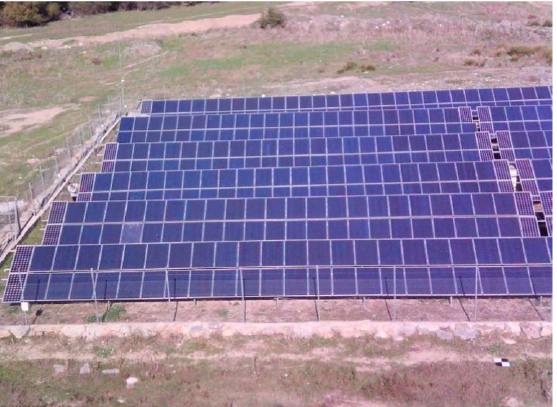
Figure 3. Aerial view of 100 kW PV plant in southern Spain. It can be seen that PV modules with different technologies are located at the ends of the arrays.